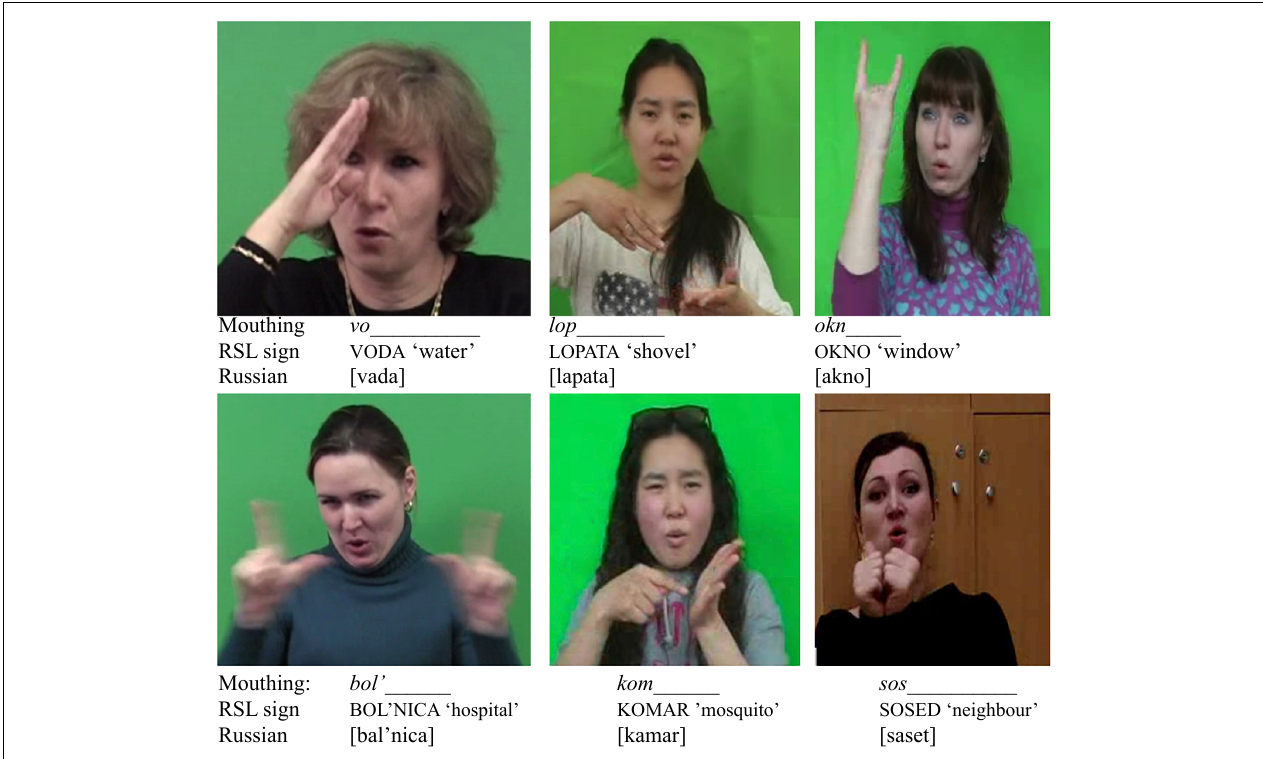
FIGURE 12 | RSL signs and mouthings with rounded vowels. Reproduced with permission from Svetlana Burkova (Novosibirsk State Technical University), available at the online corpus of Russian Sign Language, http://rsl.nstu.ru/.